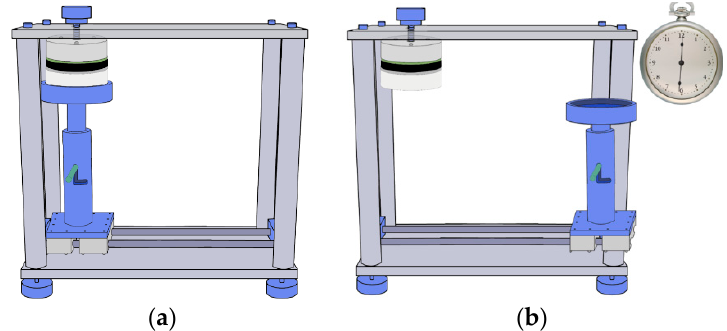
Figure 9. Test method for adhesion on wet substrate; ( a ) specimen placement; ( b ) water flow testing.